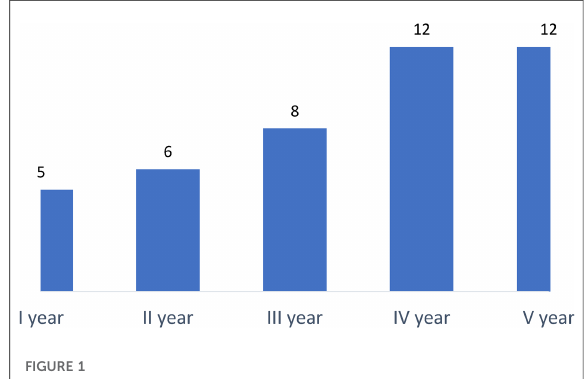
FIGURE 1 Graphical representation of 43 respondents who left their surgical training divided according to the attended year of